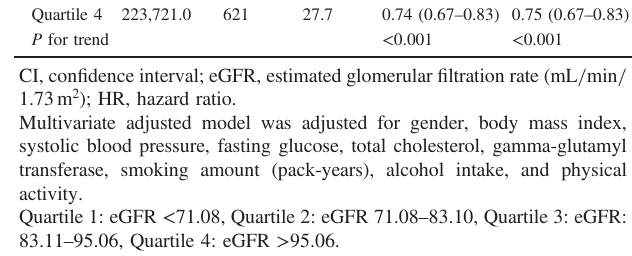
Table 1. Hazard ratios (HRs) and 95% con fi dence intervals (CI) for the incidence of cholelithiasis according to the quartile levels of eGFR HRs (95% CI) + Incidence Incidence Person-years multivariate cases rate unadjusted adjusted model